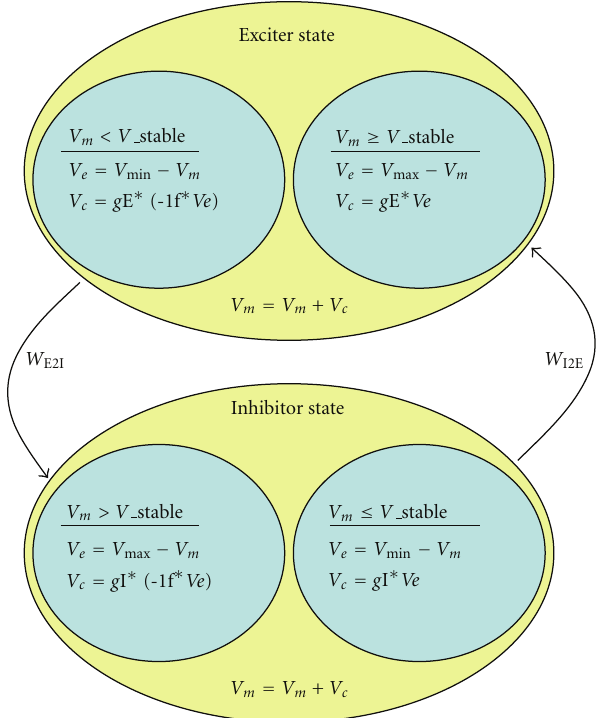
Figure 10: This figure shows an algorithm/data flow diagram for the smooth4 neural oscillator. As before, proportional controllers are used to generate values for V m . However, this time two substates are contained in each of the primary